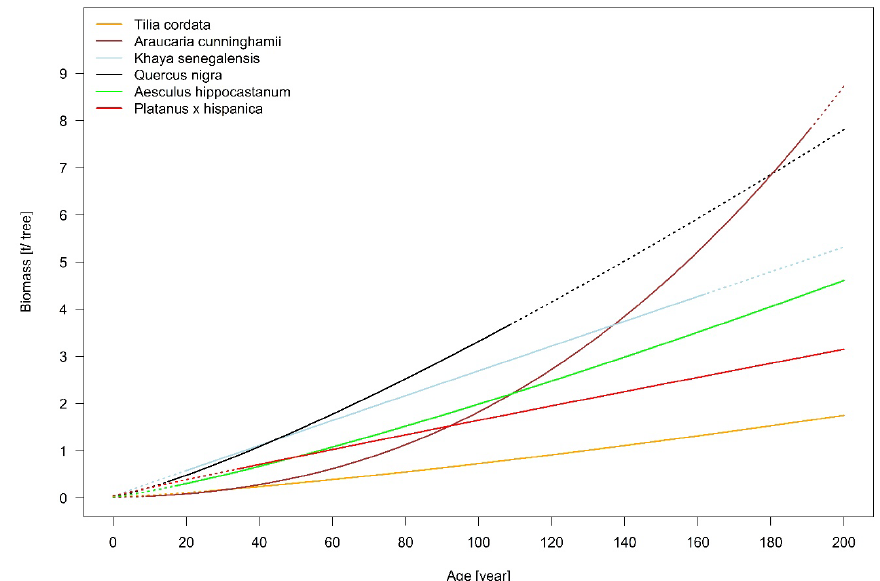
Figure 3. Estimated aboveground woody biomass for six tree species in urban environments, based 304 on allometric equations. The data include the correction factor of 0.8 for transferring a stand biomass 305 equation to urban trees. Dotted lines show projections which are not covered by measured data. 306 A comparison of the calculated carbon storage based on the measured tree parameters are shown 307 in Figure 4, taking all available trees and the resulting average age into account (Tables 1 and 2). A. 308 hippocastanum has the highest range from 122 to 4575 kg per tree and on average has 1106 kg per tree 309 stored carbon; trees with lesser capacity include P. x hispanica (188–3038 kg per tree), Q. nigra (133– 310 2145 kg per tree), and K. senegalensis (290–2161 kg per tree), the lowest values, as well as the smallest 311 range, are attributed to T. cordata (71–1087 kg per tree) and A. cunninghamii (12–3531 kg per tree). The 312 difference between the carbon storage (Figure 4) and the estimated biomass (Figure 3) is due to a 313 variation in diameter at breast height ( dbh )-range between the species, which can be seen in Table 2. 314